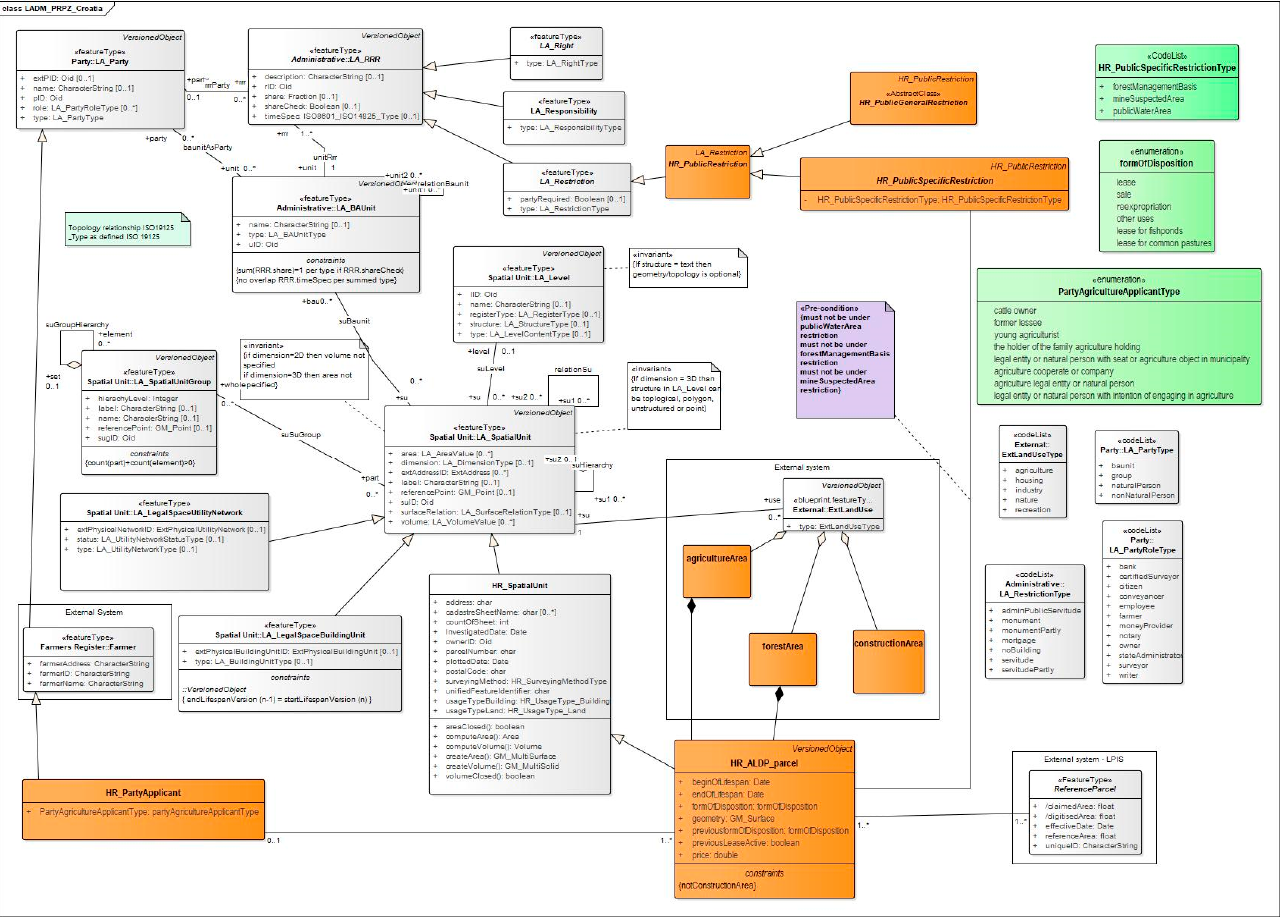
Figure 5. State-owned Agricultural Land Management extension application schema with relations to other classes (the orange and green background color presents newly added elements).